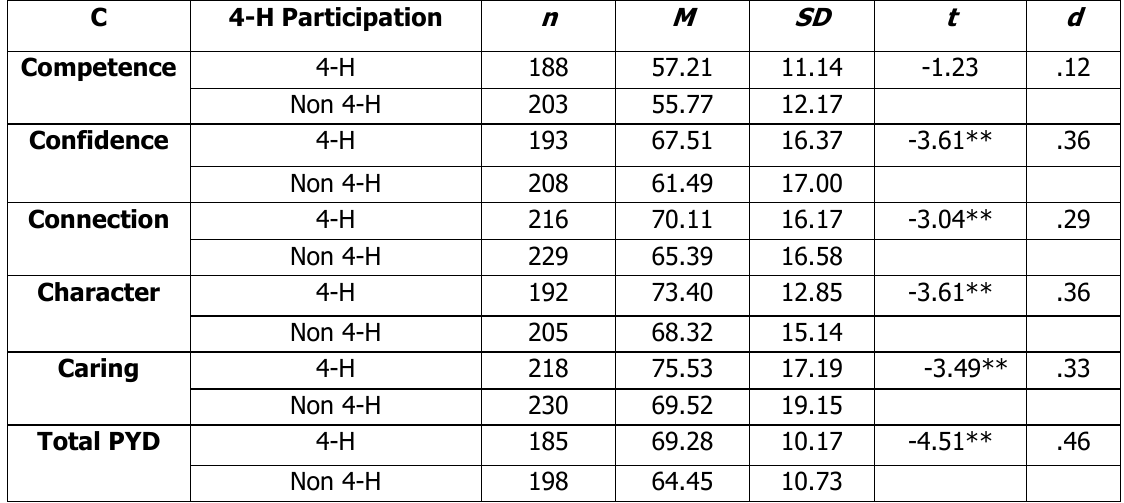
T-test Results for Five C’s Between 4-H and Non-4-H